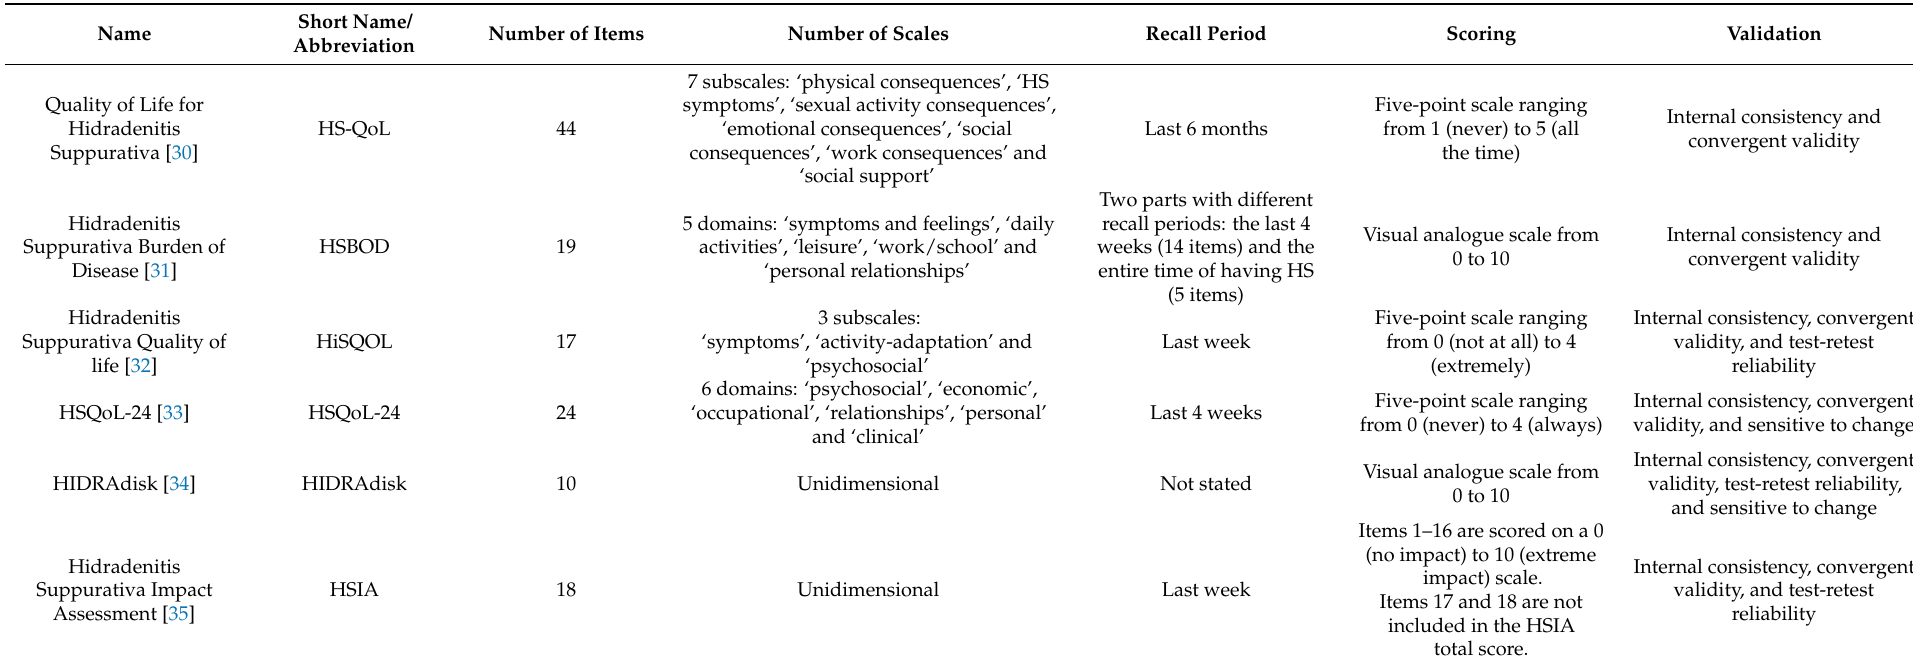
Table 1. HS-specific HRQoL